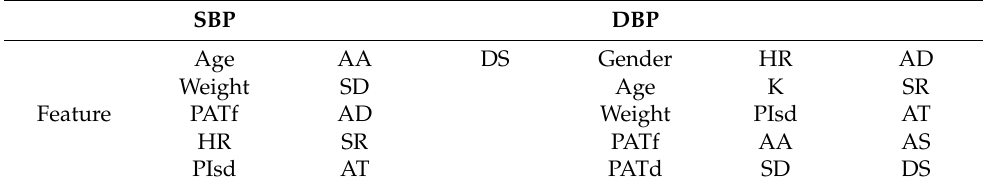
Table 2. Optimal feature subset for SBP and DBP.